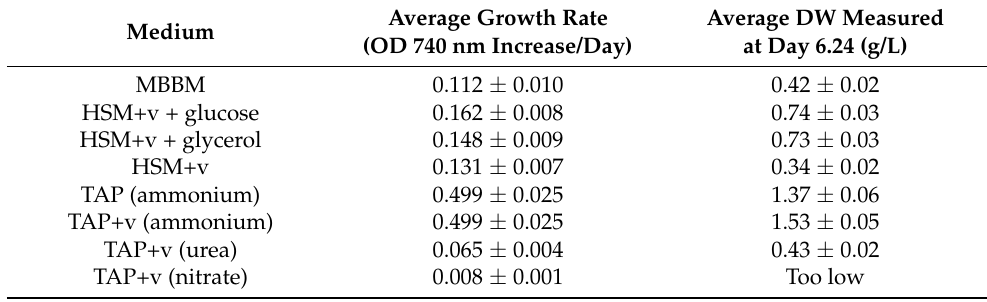
Table 1. Calculated average growth rates of Chlorella variabilis expressed in average change in OD value per day ± standard deviation and measured DW in g/L expressed as average ± standard deviation measured at day 6.24. All experiments were carried out with 3 biological replicates.